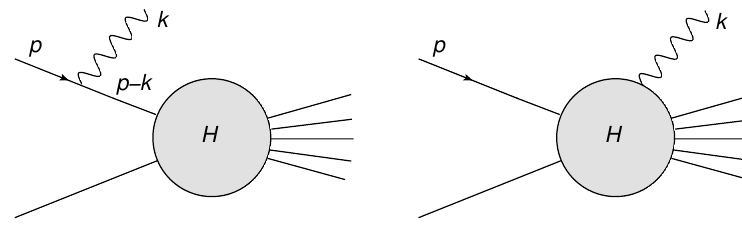
Figure 1 . Diagrammatic representation of an external emission (left) and internal emission (right) in a scattering amplitude. The blob H represents a generic subdiagram sensitive to the unspecified hard